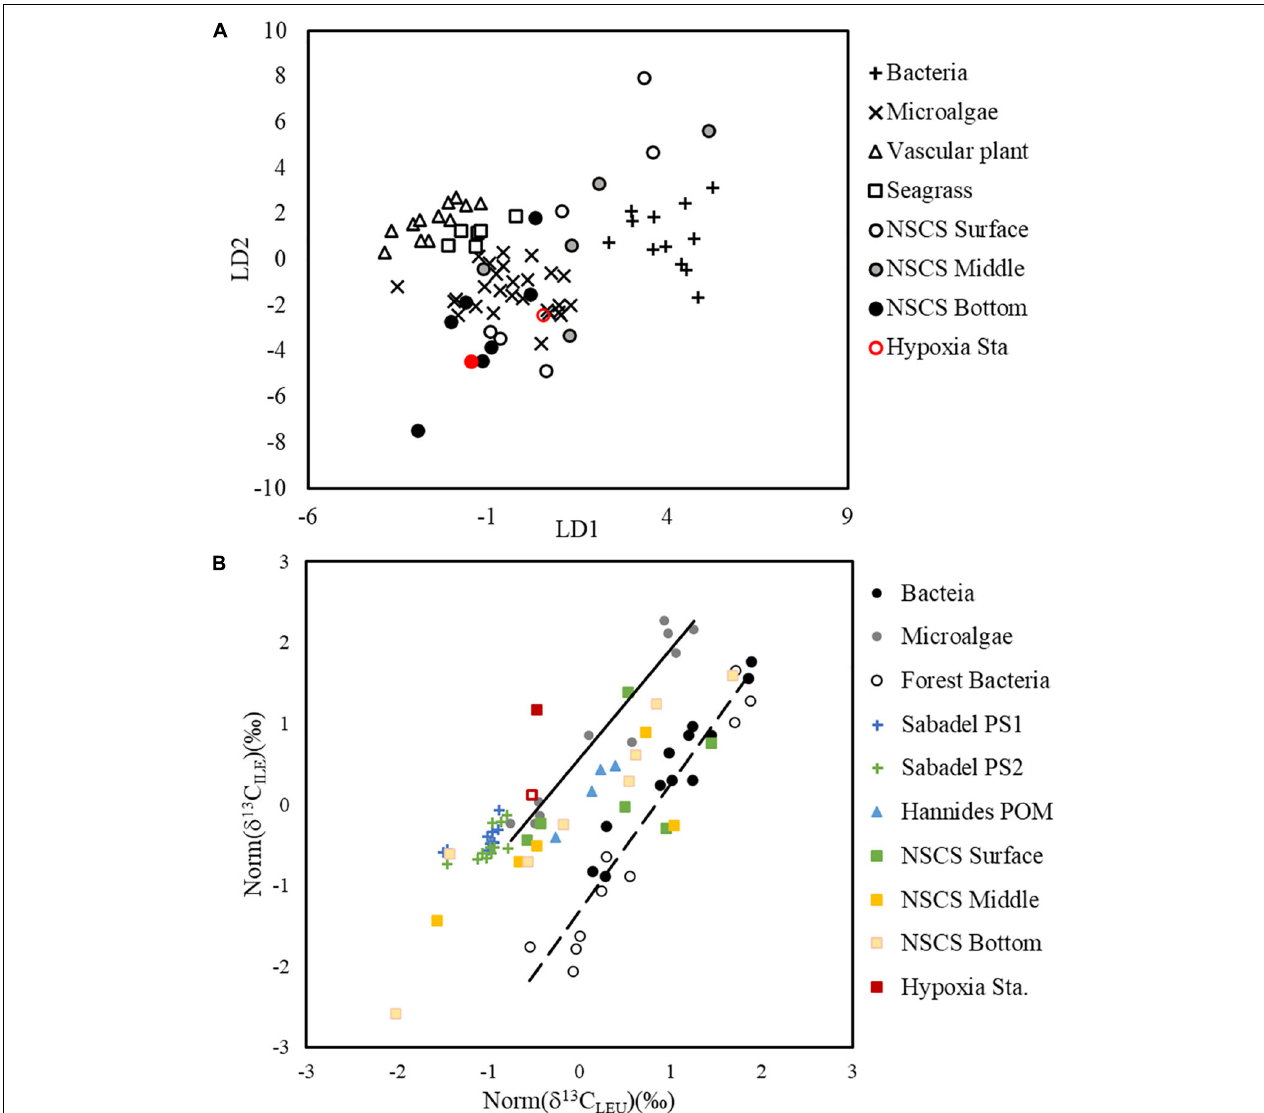
FIGURE 7 | Linear discriminant analysis of essential amino acid δ 13 C values from surface, mid-depth, and bottom particles sampled on the NSCS shelf as well as particles from the hypoxic station F303H (A) . The training dataset of bacteria, microalgae, vascular plant, and seagrass are from Larsen et al. (2009), Larsen et al. (2013). Normalized δ 13 C values of leucine and isoleucine (B) . The bacteria (Larsen et al., 2013, 2015), forest bacteria (Larsen et al., 2009), microalgae (Larsen et al., 2013, 2015), Atlantic POM (Sabadel et al., 2019), and Pacific POM (Hannides et al., 2013) were used as a combined dataset for the standardization. The δ 13 C values were normalized accordingly in particles from the surface, mid-depth and bottom of the NSCS shelf. The solid and dashed lines are regression lines of microalgae and